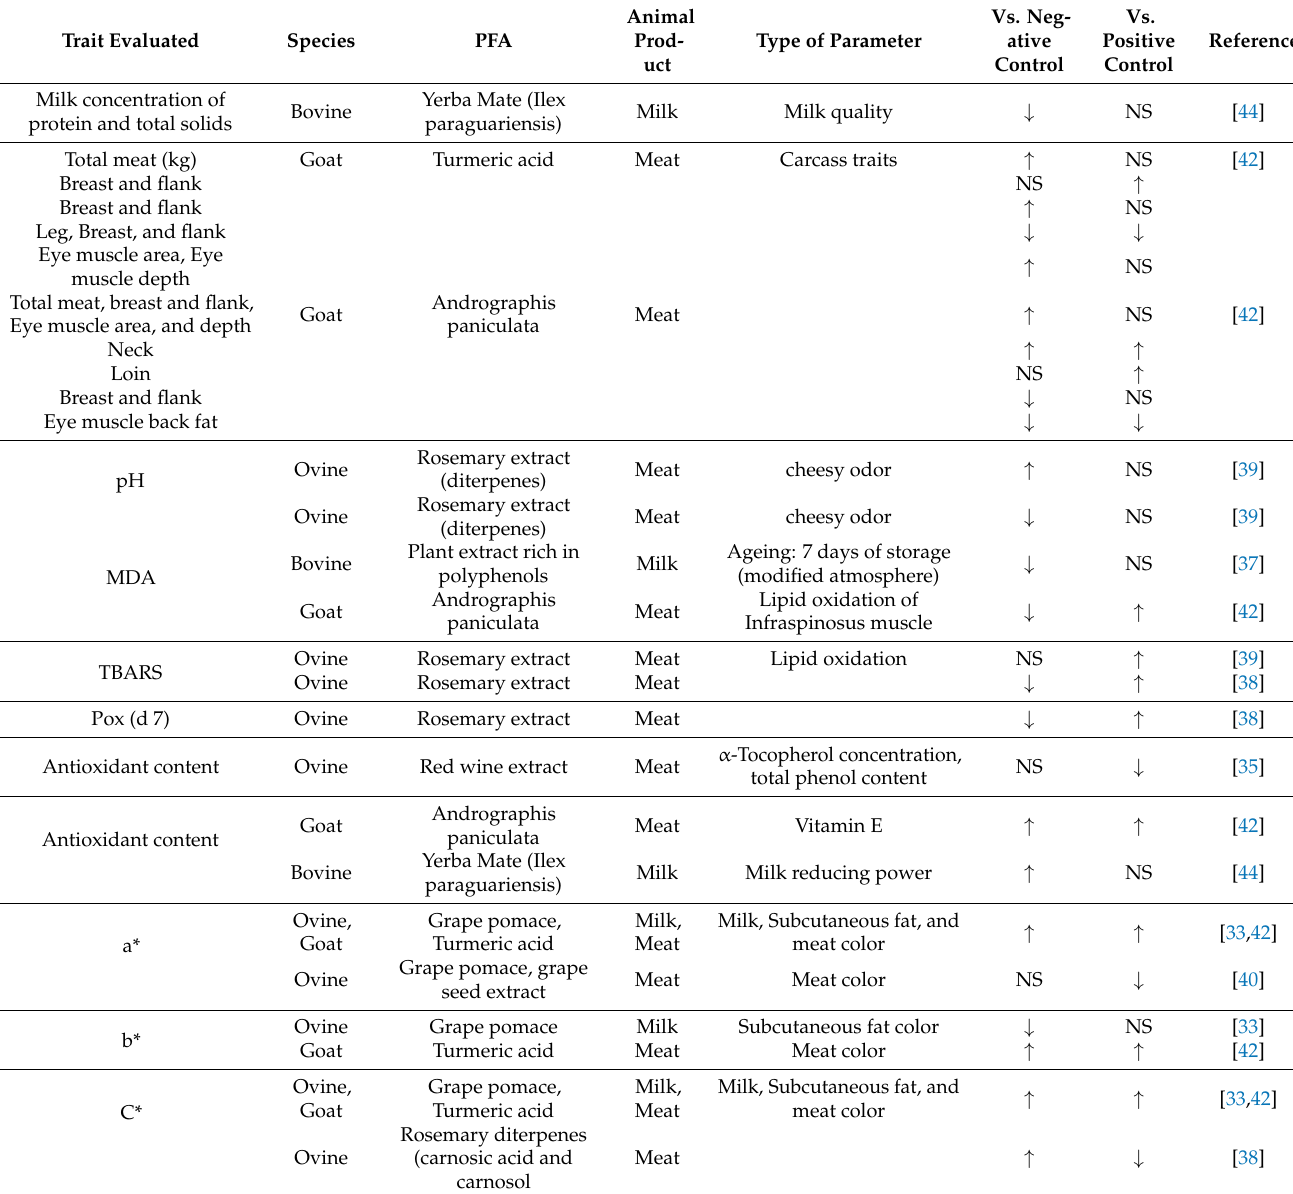
Table 2. Effects on quantitative and qualitative traits of lamb meat and cattle and sheep milk. Trait Evaluated Species PFA